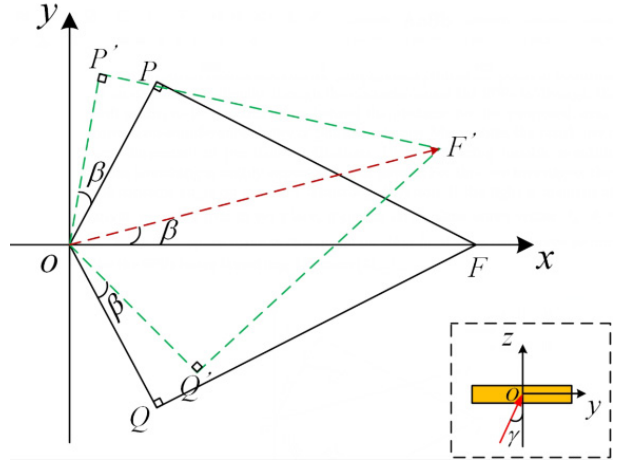
Figure 3. The vector relationship of the k in and the nondiffracting SPP-beam launching direction (the inset shows the incident light direction). The line segments OP and OQ, respectively, are the equiphase lines of the SPP beams excited by the upper and lower nano-rectangular slot arrays when 0 γ = ; the line segments OP ′ and O Q ′ , respectively, are the equiphase lines of the SPP beams excited by the upper and lower nano-rectangular slot arrays when 0 γ ≠ ; OF is the nondiffracting SPPs beam launching direction when 0 γ = ; and OF ′ is the nondiffracting SPP-beam launching direction when 0 γ ≠ .